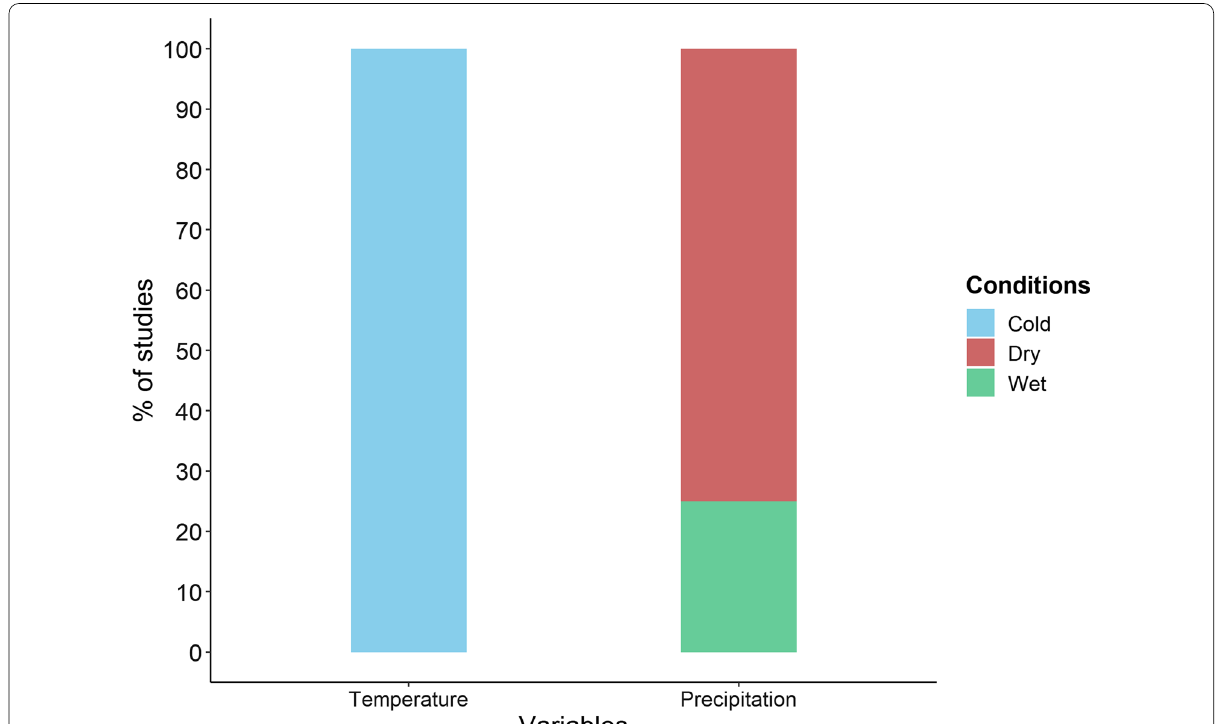
Fig. 7 Relationship of temperature and precipitation during the 8.2 ka cold event. The number of studies used for the warm/cold or wet/dry conditions can be found in Table